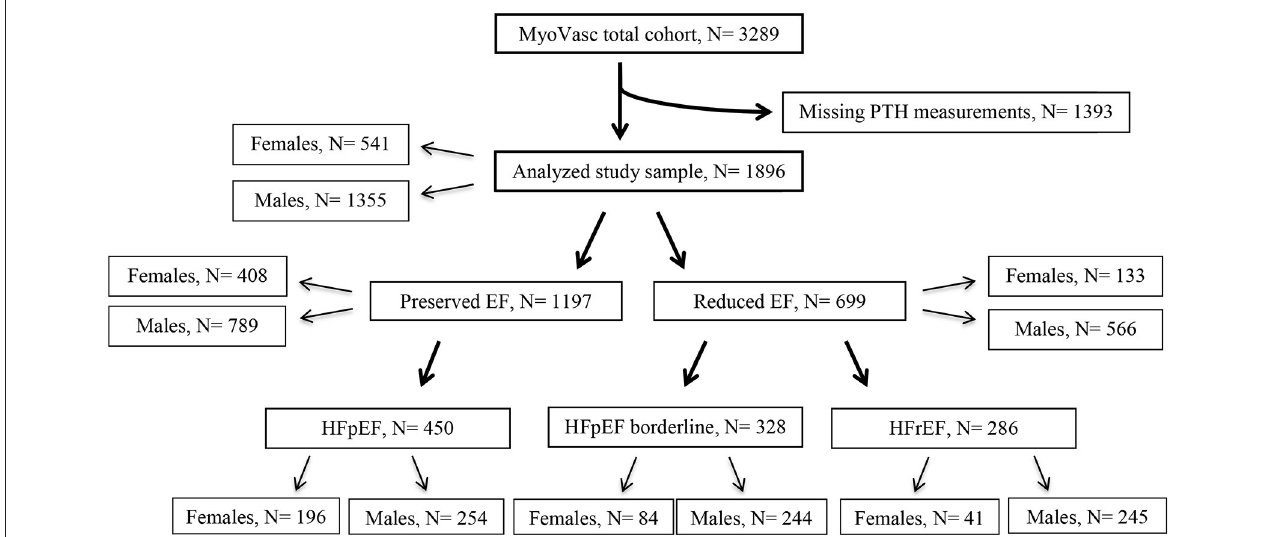
FIGURE 1 | Derivation of the analysis sample. Flow chart presenting the derivation of the analysis sample based on measurements of PTH and ejection fraction. N , number of individuals; PTH, parathyroid hormone; EF, ejection fraction; HFpEF, heart failure with preserved ejection fraction; HFpEF borderline, heart failure with LVEF 41 to 49%; HFrEF, heart failure with reduced ejection